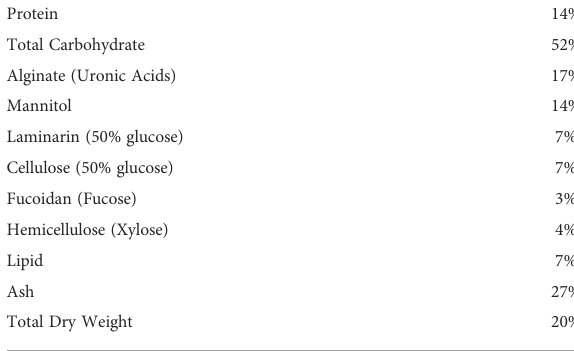
TABLE 1 Macromolecular composition of Saccharina latissima . Protein Total